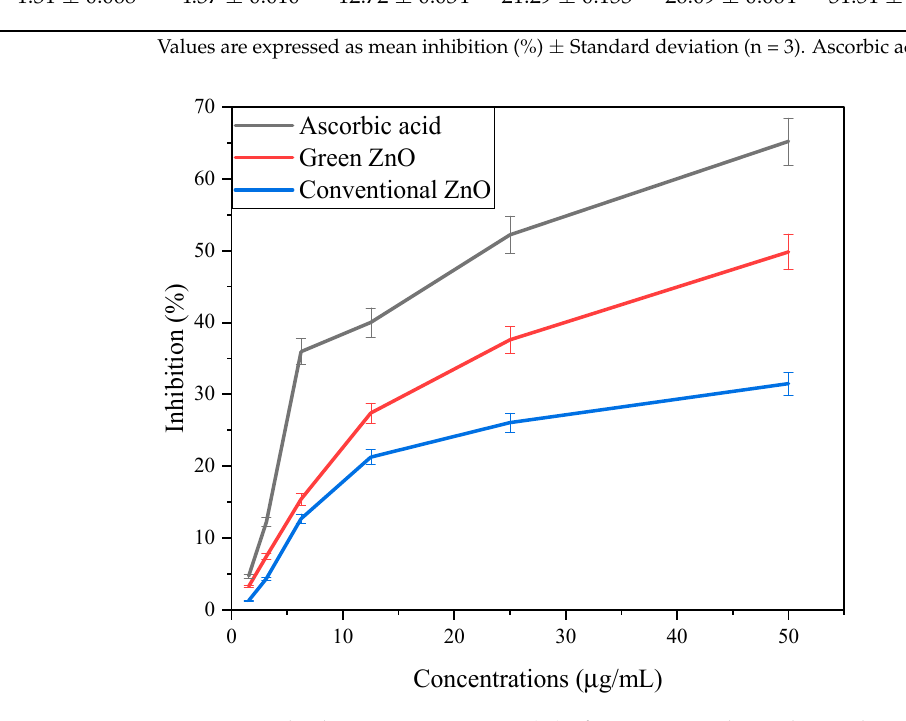
Figure 8. Radical scavenging activity (%) of ZnO-NPs and ascorbic acid at various concentrations.